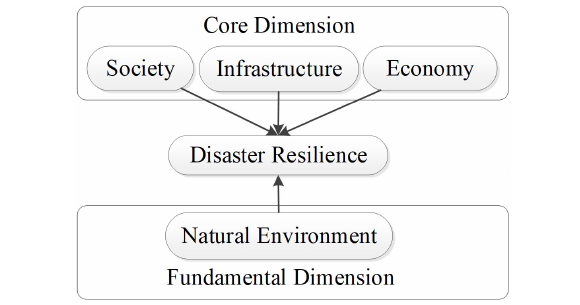
Fig. 5 . Theoretical framework for measuring disaster